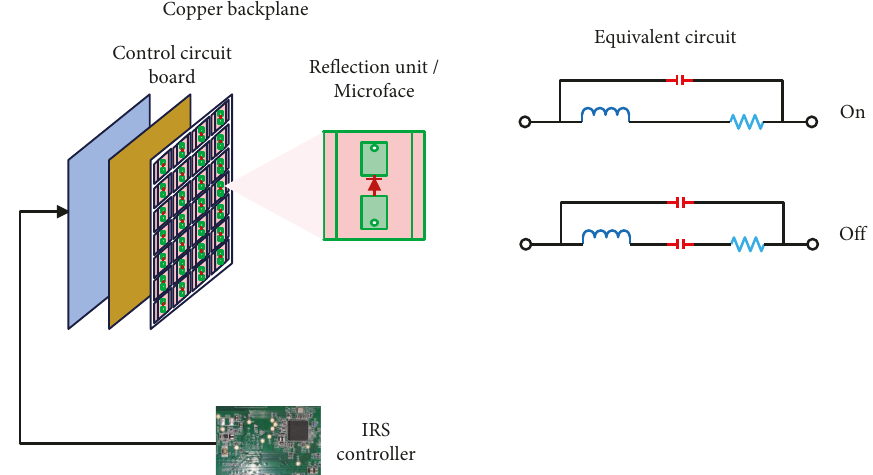
Figure 1: The hardware architecture of the smart reflector.